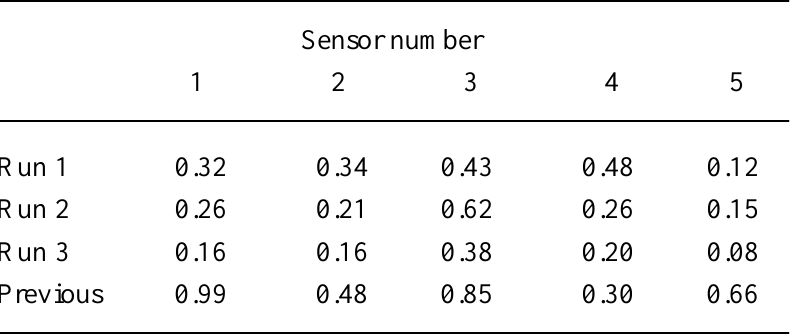
Table 1 . Comparison of standard deviations among five measurements in the three runs of this study and a run of a previous